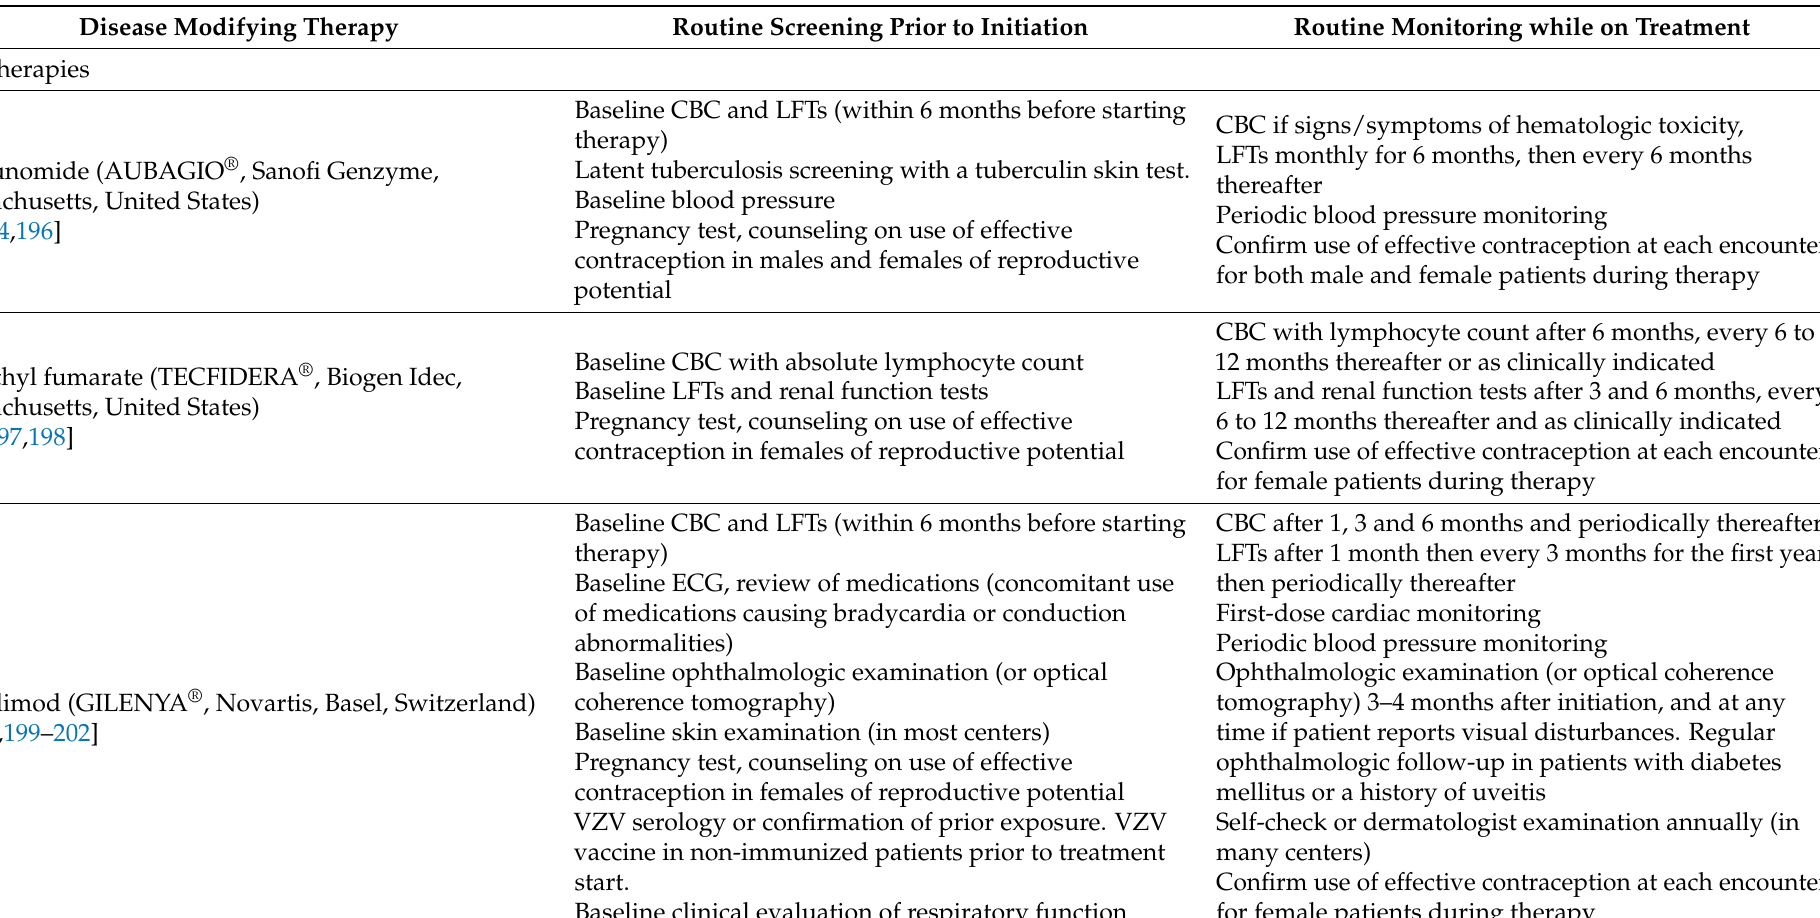
Table 2. FDA Recommended Pre-Treatment Screening and Monitoring during Treatment with Newer Disease Modifying